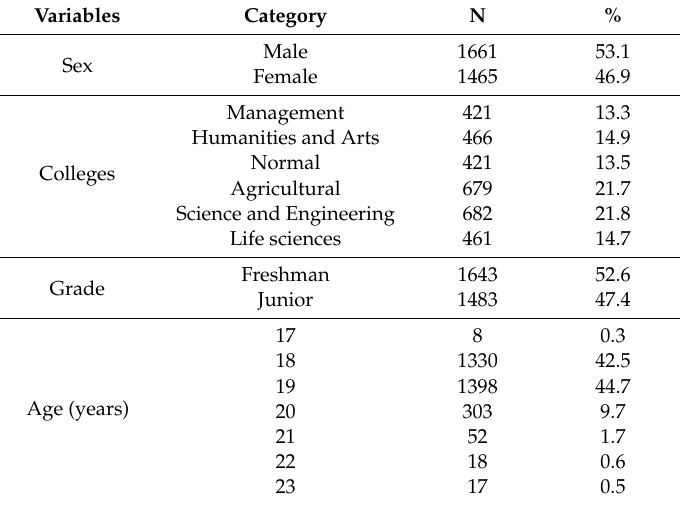
Table 1. Demographics of the participants.